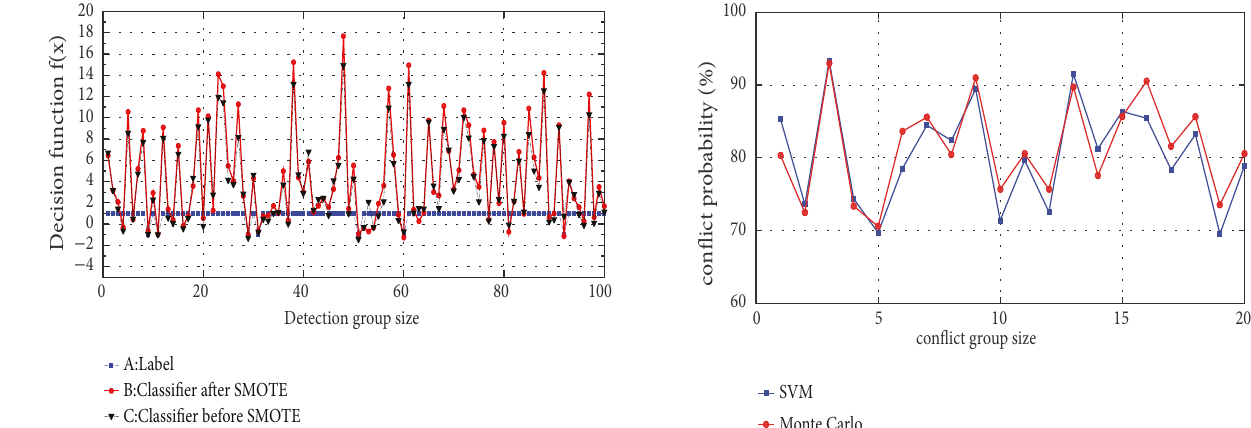
Figure 6: Comparison of conflict probability between SVM and Monte